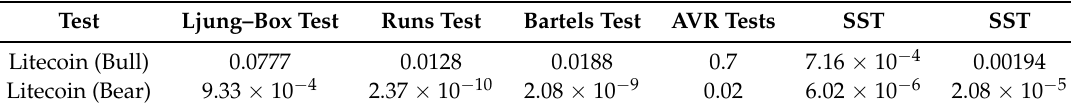
Table 5. Market-efficiency test for hourly returns of Litecoin during bull and bear